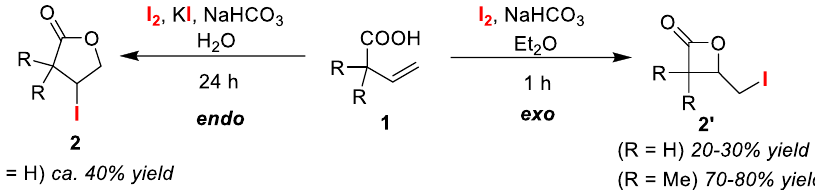
Figure 2. An early reported reagent-switchable reaction enabling endo / exo selective iodolactonization.